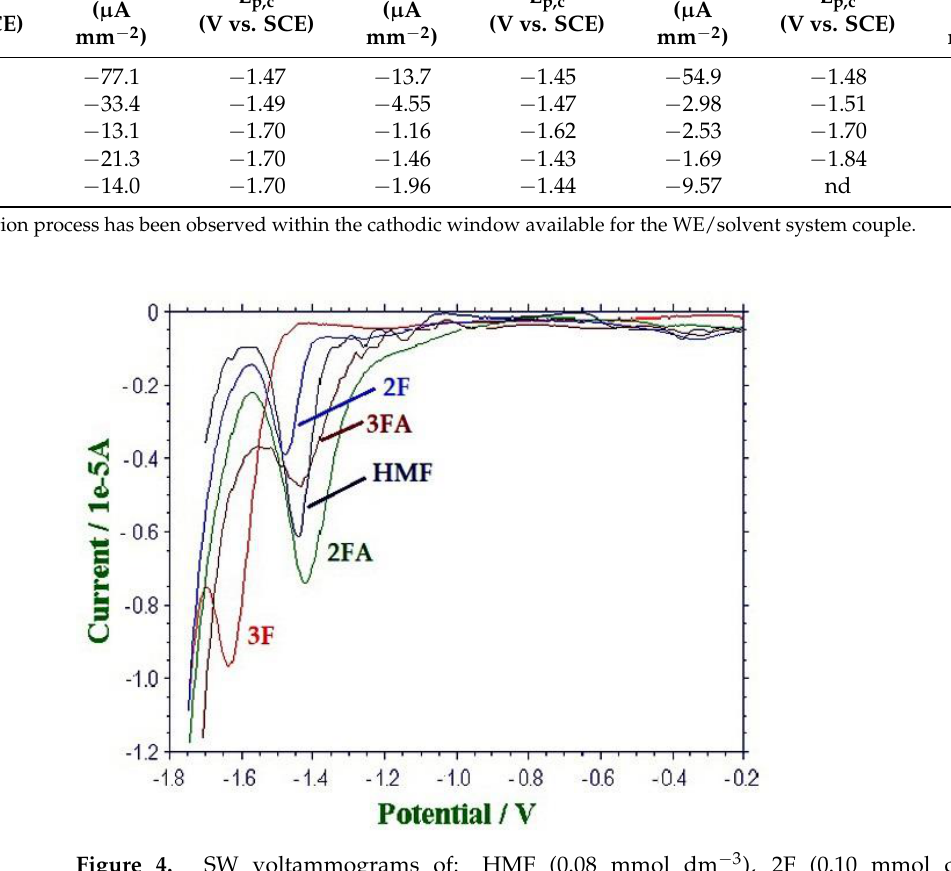
Figure 4. SW voltammograms of: HMF (0.08 mmol dm −3 ), 2F (0.10 mmol dm −3 ), 3F (0.62 mmol dm −3